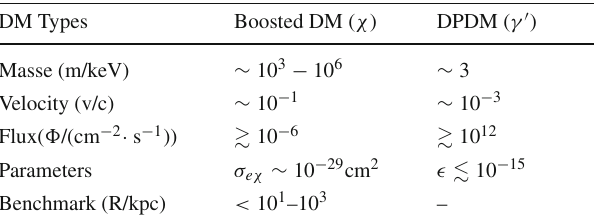
Fig. 5 The data points and background curve B 0 are reproduced from the Xenon1T data and the background model in [1]. The red dashed line is produced from the boosted dark matter (BSD) model accelerated by theblackholes.Thislineisschematicallyproducedasin[69],with v χ (cid:4) 0 . 1 c and other benchmark parameters in Table 3. Here we smear the recoil energy in equation (8) with the Rayleigh distribution, considering the detector resolution. The blue dashed line denotes the signals of the dark photon dark matter(DPDM) with m A (cid:10) = 2 . 8 keV with resolution of1keVasin[73]andotherbenchmarkparametersinTable3.Thegreen dashed line denotes the axion flux bounded by the X-ray background in [67]. The event number is shown in the plot after being multiplied by the factor of 10